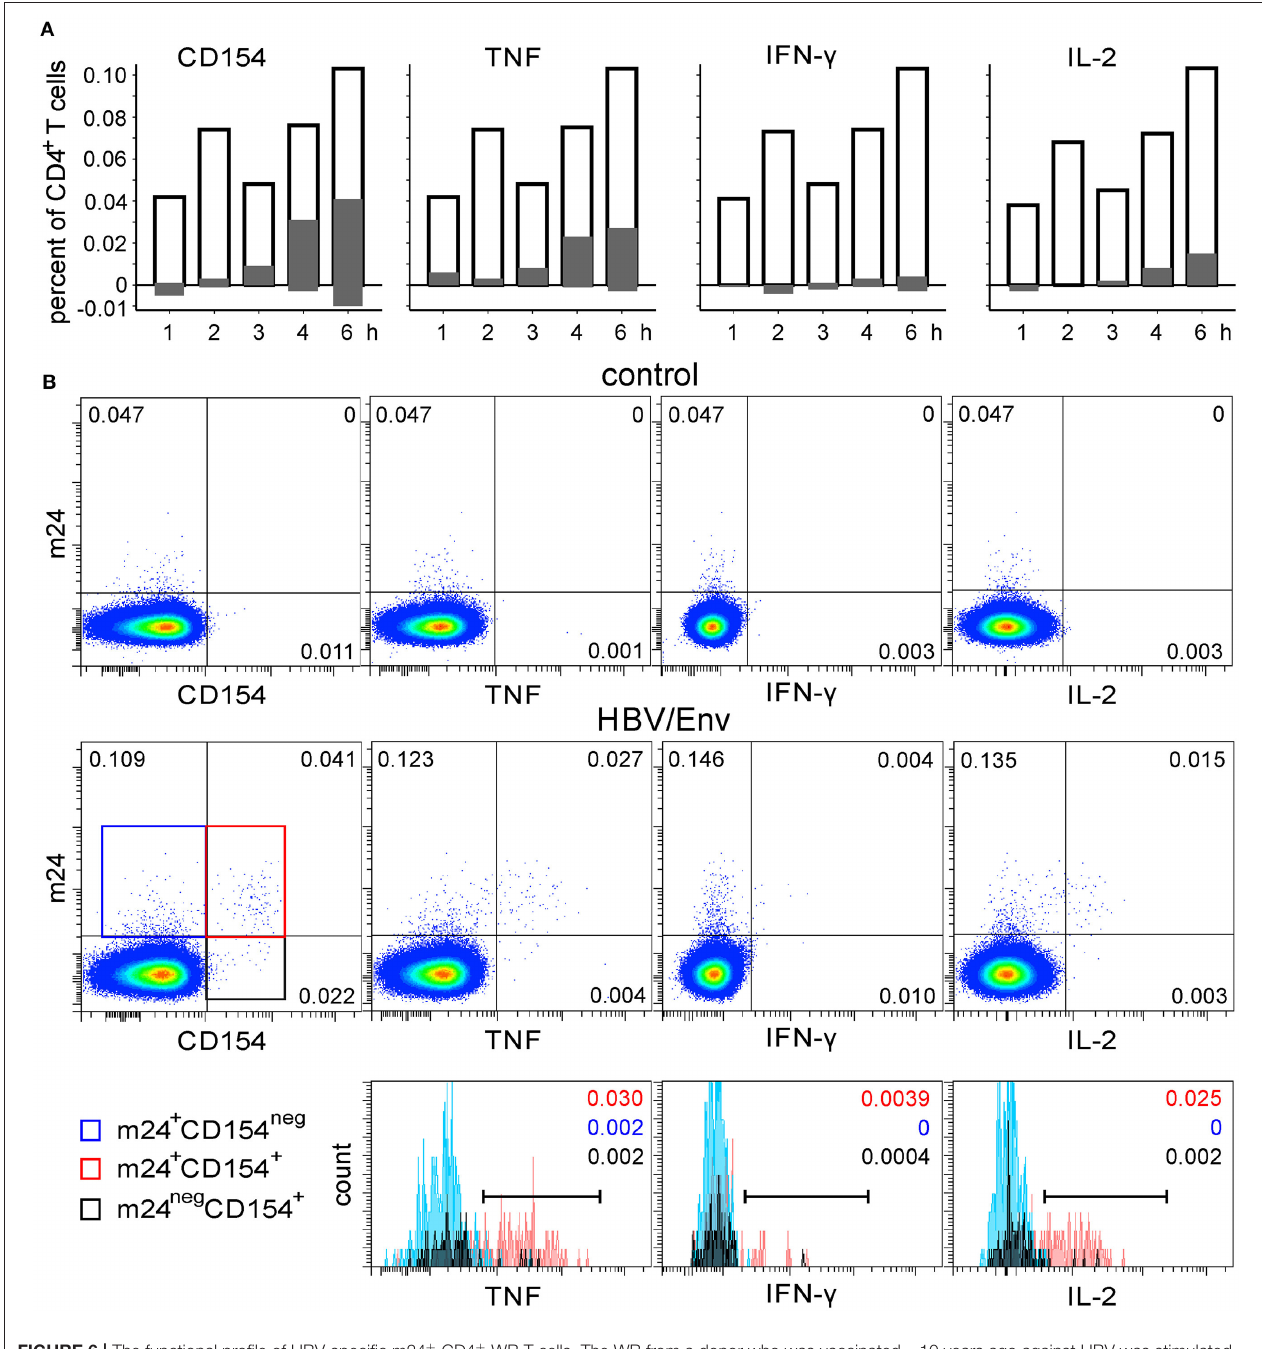
Frontiers in Immunology |